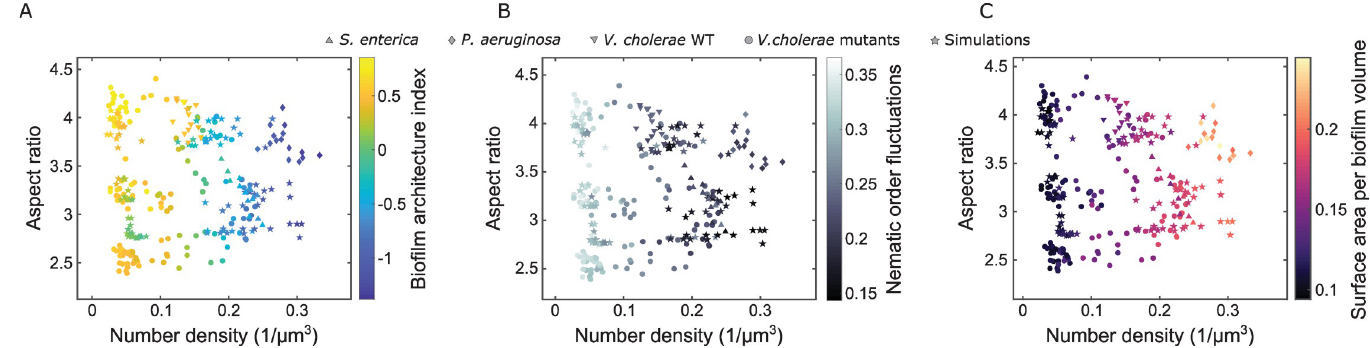
Fig 4. Joint phase diagram combining experimental biofilms from different species shown in Fig 1A with the experimental biofilms of V . cholerae mutants and the simulated biofilms from Fig 3. Each biofilm in the phase diagram is ( A ) colored by the biofilm architecture index BAI, ( B ) colored by an emergent collective property of the biofilm architecture, the variance of the nematic order parameter, and ( C ) colored by another emergent collective property, the surface area per biofilm volume. Source data are available at DOI: 10.5281/zenodo.7077624.